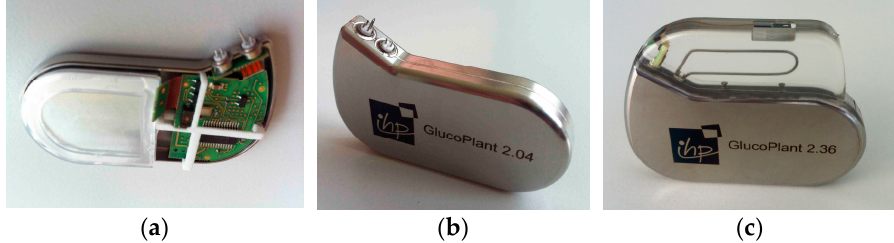
Figure 5. Biosensor implant ( a ) prior to and ( b ) after closing the Ti shucks by laser welding; ( c ) Fully implantable system including header with antenna and sensor probe (59 mm × 45 mm × 8 mm).